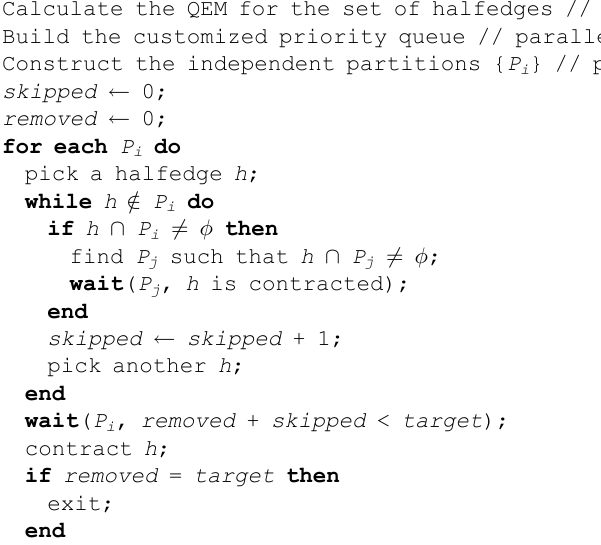
Algorithm 6: Major steps of the proposed algorithm